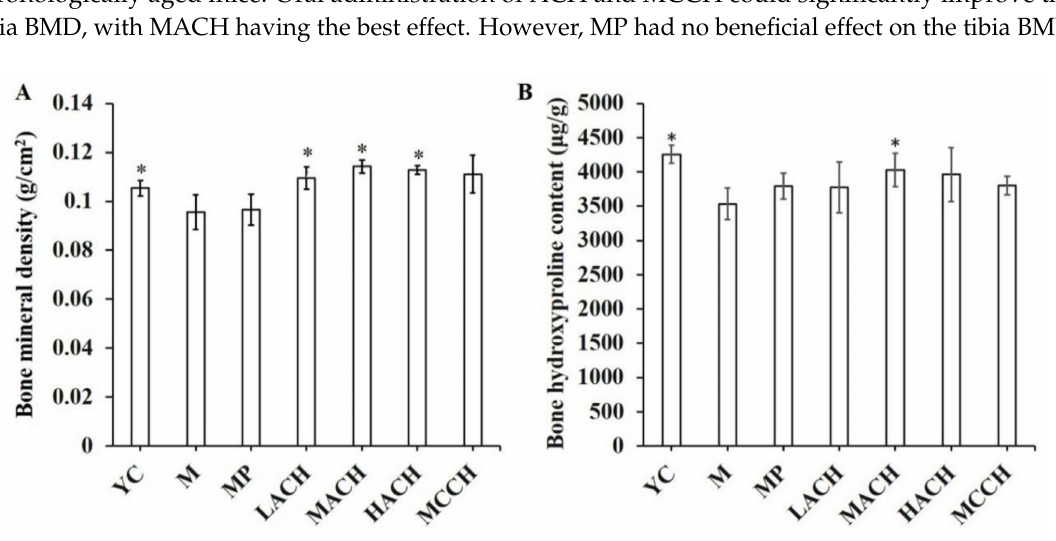
Figure 1. Effect of collagen hydrolysates on bone mineral density and hydroxyproline content in chronologically aged mice. ( A ) Bone mineral density; ( B ) Bone hydroxyproline content. YC, young control group; M, model group; MP, medium dose of proline; LACH, MACH and HACH represent the low, medium and high dose of ACH, respectively; MCCH, medium dose of CCH. * means a significant difference was observed compared to M group ( p <